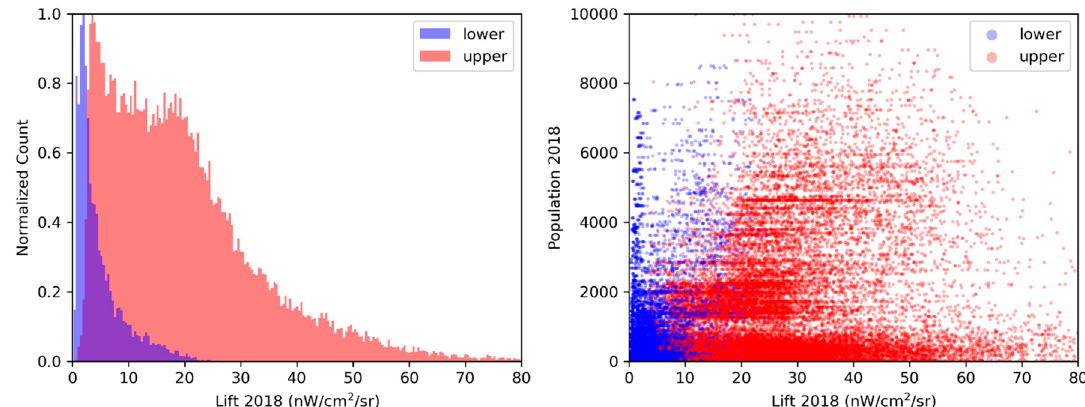
Figure 30. Histogram and scattergram of the 2018 lift index values for the developing set (Harare, Nairobi, Dhaka, and Pyongyang) versus the developed set (Houston, Seoul, Shanghai, Beijing). The developed set is red and developing set is blue. The two sets are referred to as the “lower” and “upper”, respectively. The sample set excludes grid cells deemed to be permanent background, where no lighting is detected. The scattergram is the lift index versus population count from 2018.